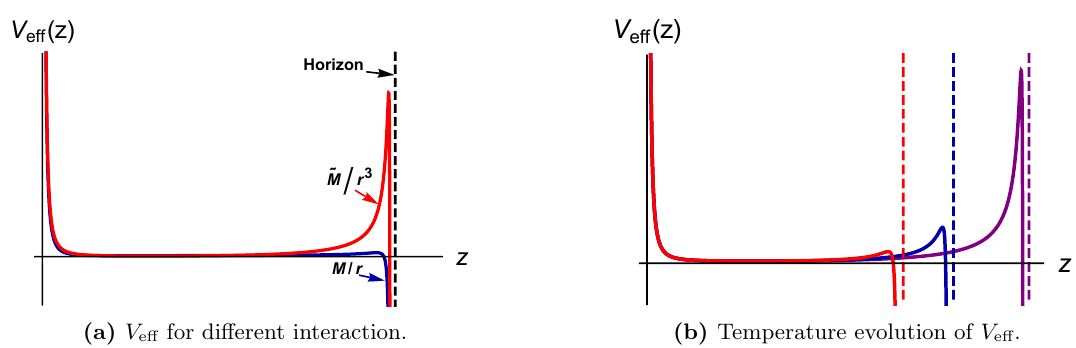
Figure 12. Schematic Schroedinger potential: (a) Comparison between M=r and ~ M=r 3 . The coordinate used is z = 1 =r . (b) Temperature evolution of the e(cid:11)ective potential in the bulk. Dashed lines are the event horizons at each temperature which moves in as T increases, and the potential changes from purple to red